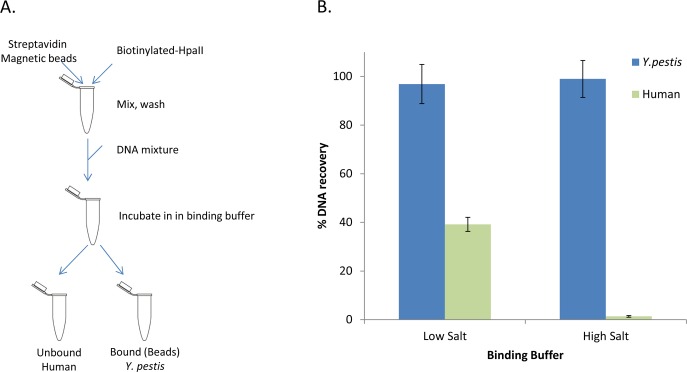
Enrichment workflow using HpaII.(A) Biotinylated HpaII enzyme is conjugated to streptavidin coated magnetic beads. A DNA mixture can then be added to the conjugated beads and following incubation the mixture is segregated into fractions that are bound (containing majority of Y. pestis) or unbound (containing majority of human) to the beads. (B) Adding salt to the binding buffer enhances segregation of human (blue bars) from Y. pestis (green bars).